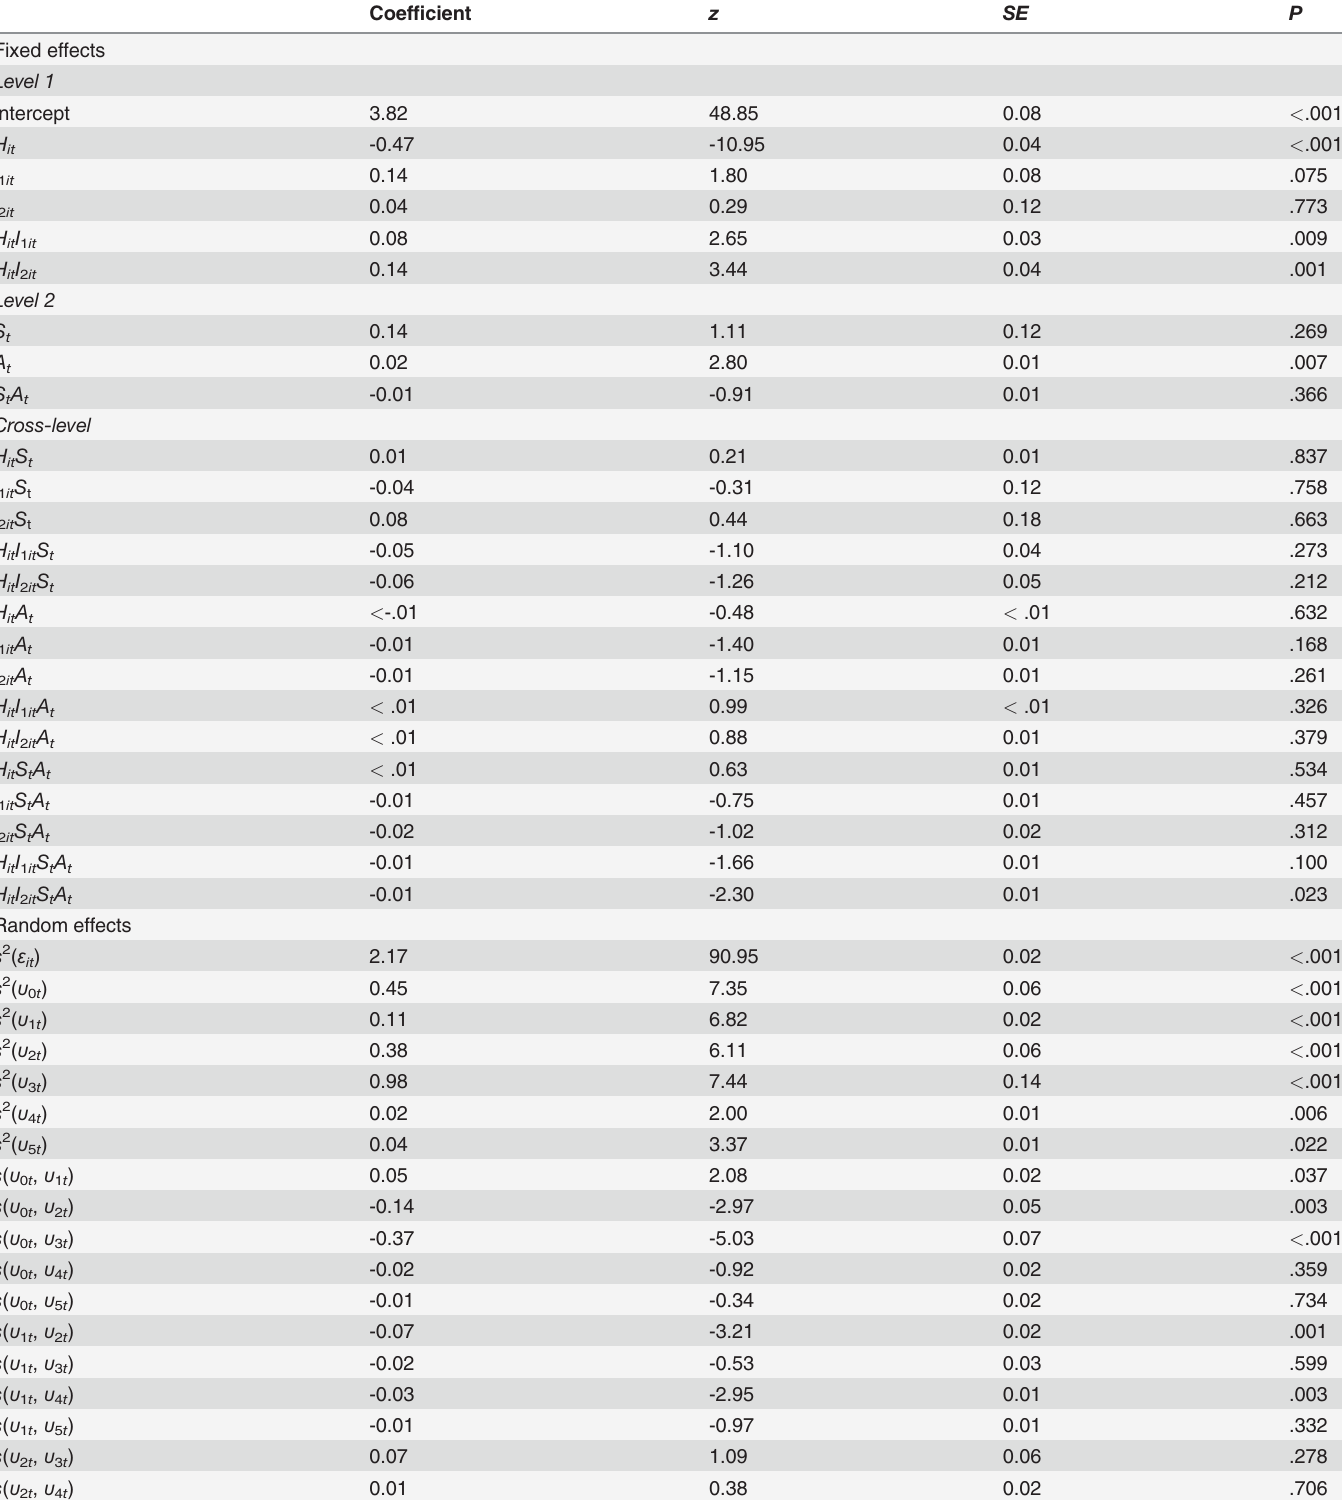
Table 8. Results of Study